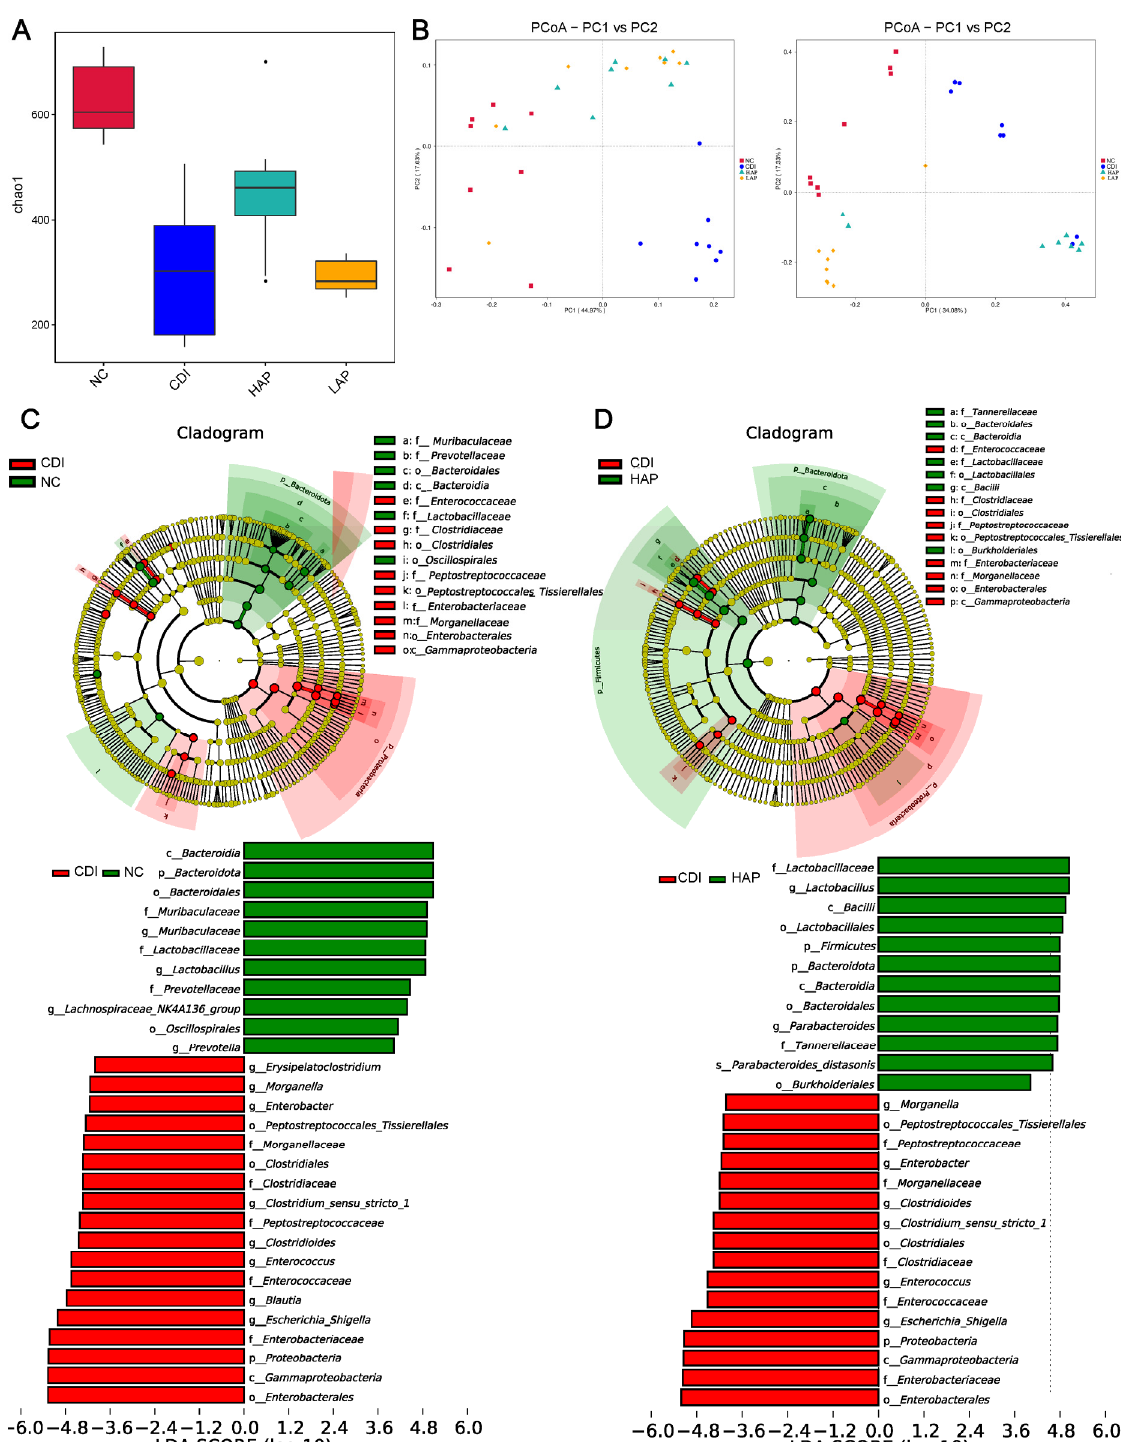
Figure 2. APE intervention changed the structure of intestinal microbiota. ( A ) Chao1 index. ( B ) PCoA plots based on weighted UniFrac ( left ) and unweighted UniFrac ( right ). ( C ) LEfSe branching plot between NC and CDI groups. ( D ) LEfSe branching plot between CDI and HAP groups. Data are expressed as mean ± SEM.